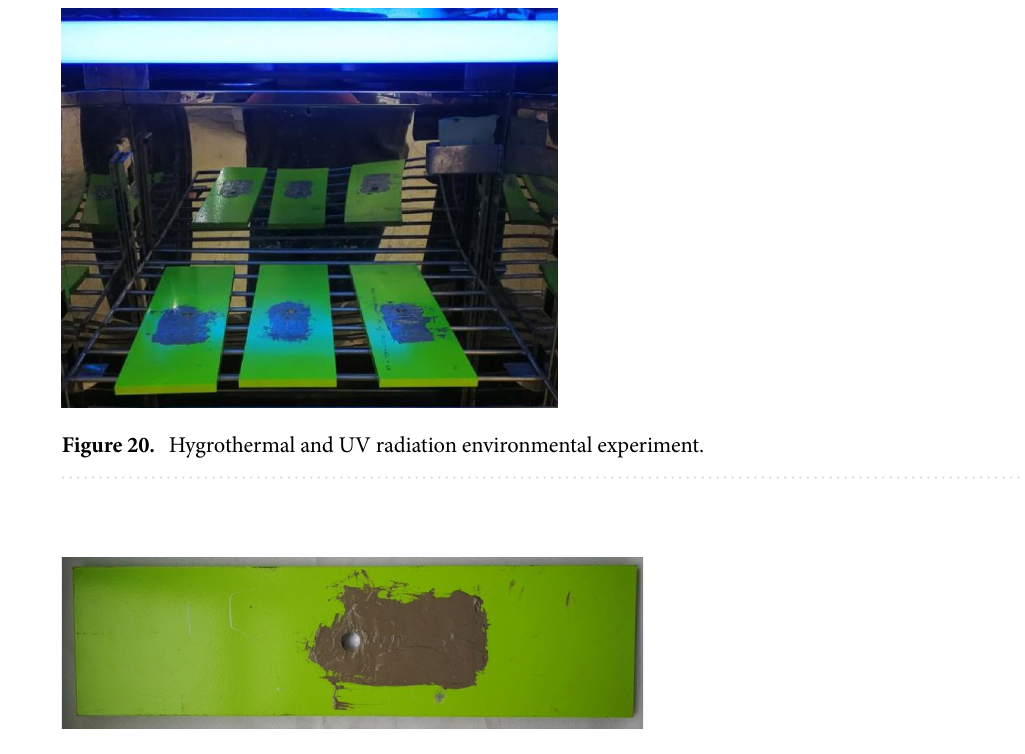
Figure 21. Surface of the specimen after Hygrothermal and ultraviolet radiation environmental